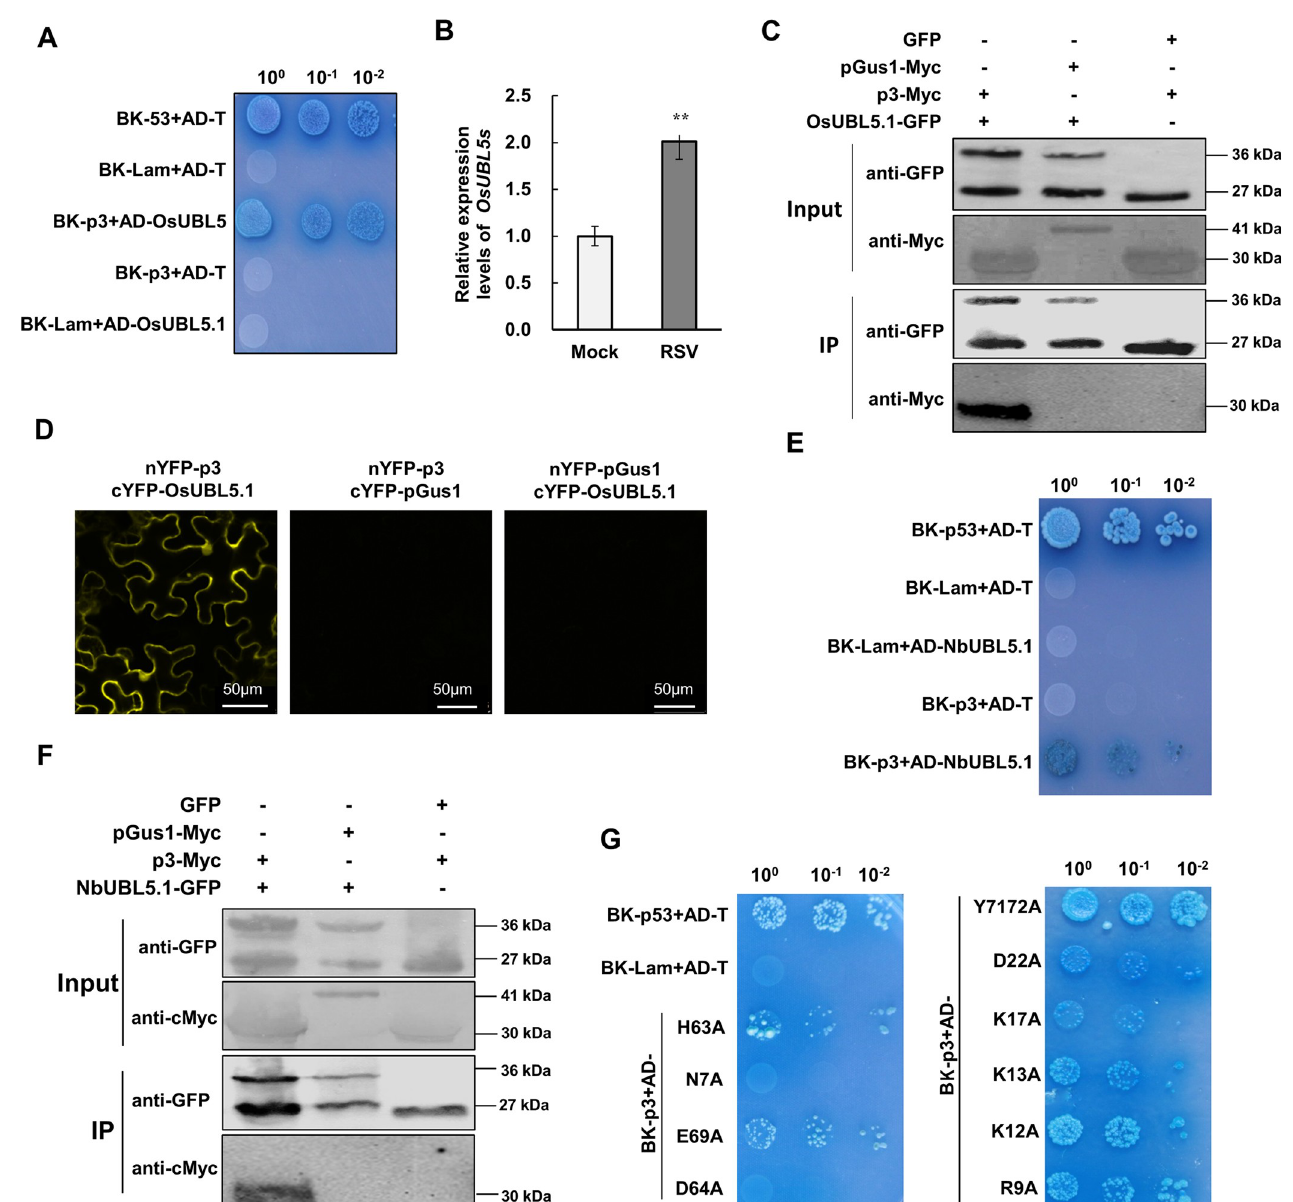
Fig 1. OsUBL5 and NbUBL5.1 interact with RSV p3. A. OsUBL5.1 interacts with RSV p3 protein in a yeast two hybrid (Y2H) assay. Yeast co-transformed with pGBK-p53+pGAD-T served as a positive control, and yeast co-transformed with vectors pGBK-Lam+pGAD-T, pGBK-p3+pGAD-T or pGBK-Lam +pGAD-NbUBL5.1 were the negative controls. Serial 10-fold dilutions of co-transformed yeast cells on synthetic defined (SD) medium (-Ade/-His/-Leu/-Trp) with X-gal are shown. B. In RSV-infected rice plants, the expression of OsUBL5s was 2.5-fold greater than in non-infected plants. C. Co-IP demonstrated the interaction between OsUBL5.1 and p3. Co-IP analysis of OsUBL5-GFP and p3-Myc expressed in N . benthamiana leaves by agroinfiltration. Separate expression of OsUBL5-GFP and p3-Myc, and co-expression of OsUBL5-GFP and pGus1-Myc were used as negative controls. The N-terminal peptide of β - glucuronidase (Gus) consisting of 306 amino acids and named partial Gus protein 1 (pGus1) was used as a non-interacting, negative control. D. BiFC assay demonstrated the interaction between OsUBL5 and p3 in the leaves of N . benthamiana at 60 h post infiltration (hpi). The N- or C-terminal fragments of YFP were fused to the N-terminus of p3 and OsUBL5. Bars, 50 μ m. E and F. Y2H and Co-IP demonstrated the interaction between NbUBL5.1 and p3. G. Detection of interaction between NbUBL5.1 mutants and p3 by Y2H assay showing that mutants R9A and D64A did not interact with p3. https://doi.org/10.1371/journal.ppat.1008780.g001 alanine in one mutant (Y7172A). In Y2H assays, mutants N7A and D64A did not interact with p3, K17A seemed to have a somewhat weakened interaction but the other mutants interacted